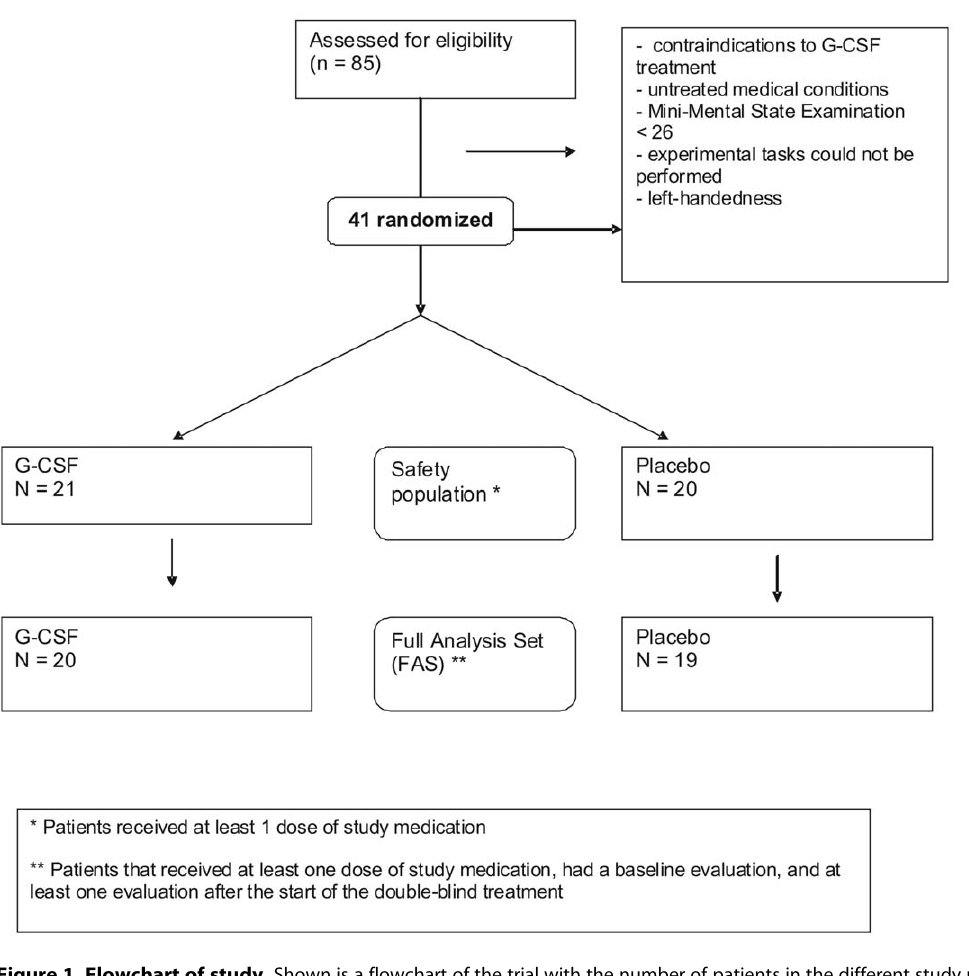
Figure 1. Flowchart of study. Shown is a flowchart of the trial with the number of patients in the different study populations (safety and FAS (full analysis set)).